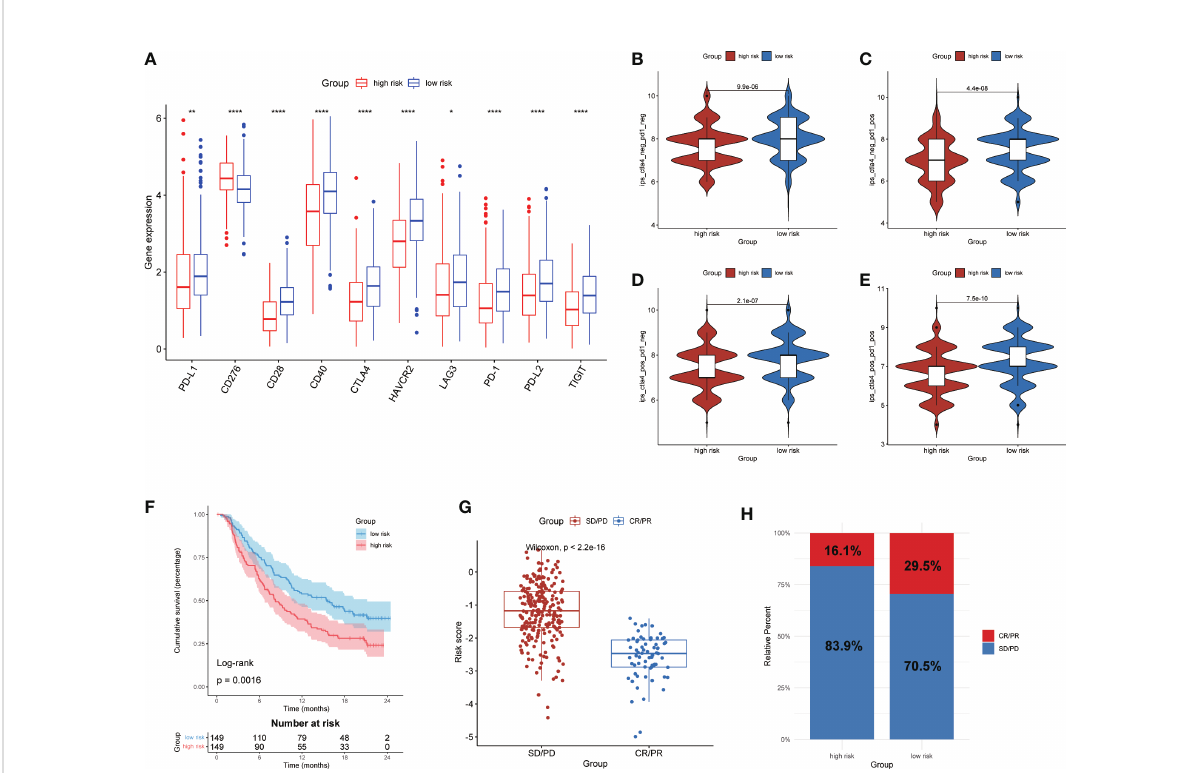
FIGURE 8 Prediction of immunotherapy response. (A) Expression of 10 immune checkpoints between high- and low-risk groups. Comparison of IPS in two groups. (B) CTLA4 negtive /PD-1 negtive . (C) CTLA4 negtive /PD-1 positive . (D) CTLA4 positive /PD-1 negtive . (E) CTLA4 positive /PD-1 positive. (F) Kaplan – Meier analysis of OS by CMRG signature for patients in the IMvigor210 cohort (P=0.0016). (G) Difference of risk score between different response groups. (H) Proportions of anti-PD-L1 immunotherapy response in high- and low-risk groups. CR, Complete Response, PR, Partial Response, SD, Stable Disease, and PD, Progressive Disease. P values were shown as: *p < 0.05; **p < 0.01; ****p <